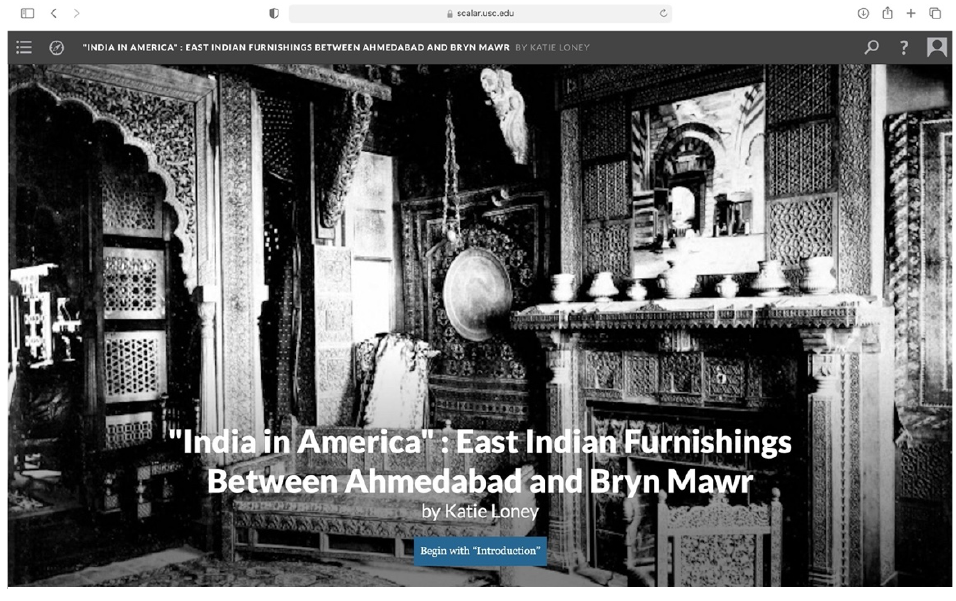
Frontpage of “India in America”: East Indian Furnishings between Ahmedabad and Bryn Mawr by Katie